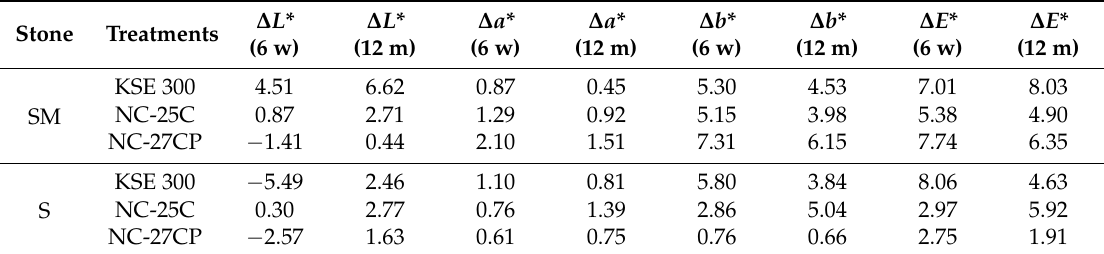
Table 5. Colour values measured on sound St. Margarethen Limestone (SM) and Schlaitdorf Sandstone (S) before and after treatment at different intervals: six weeks (6 w) and twelve months (12